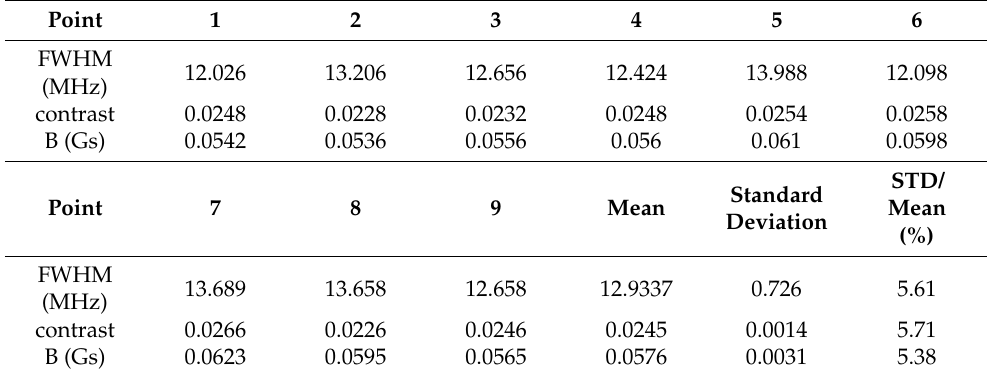
Table 3. Statistical analysis of FWHM, contrast, and simulated magnetic field intensity B at different points in Figure 2a.